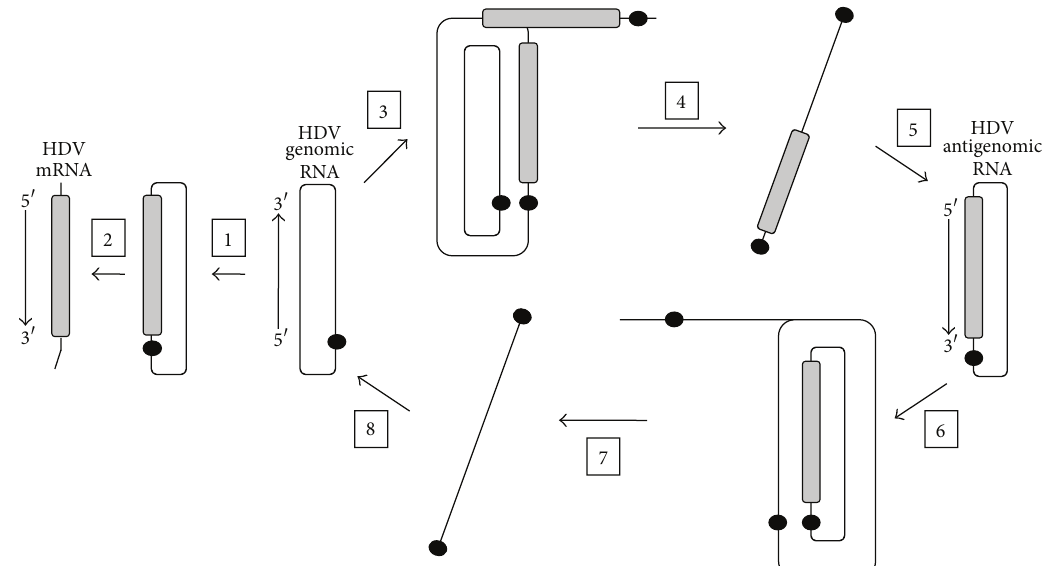
Figure 2: Model of HDV replication through a rolling-circle mechanism. The HDV genomic RNA is used as a template for the precursors of HDV mRNA (Steps 1-2) and also acts as a template for multimeric RNAs of antigenomic polarity (Step 3). These multimeric RNAs contain at least two copies of the HDV ribozyme and are thus self-cleaved to produce linear unit-length HDV antigenomes (Step 4), which are then ligated to produce circular antigenomic RNA (Step 5). In turn, the new antigenomic RNA is a template for multimeric RNAs of genomic polarity (Step 6) that are similarly self-cleaved and subsequently ligated to produce new circular genomic RNA (Steps